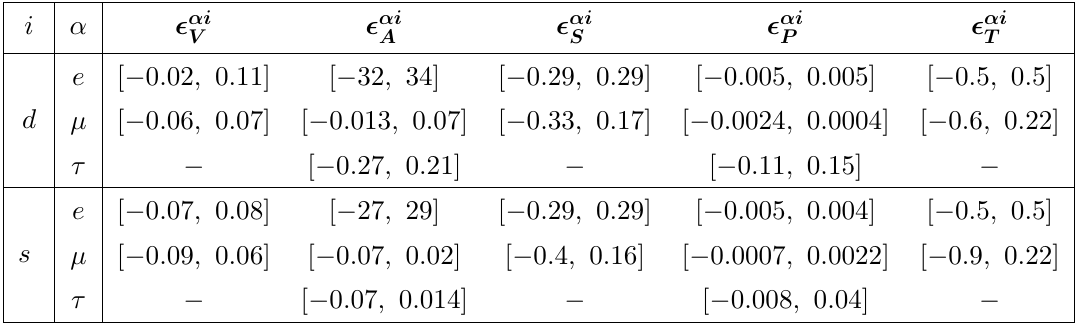
Table 2 . 95% CL ranges of the WCs of the charged-current operators obtained at the scale µ = 2 GeV from current experimental data on (semi)leptonic D to be